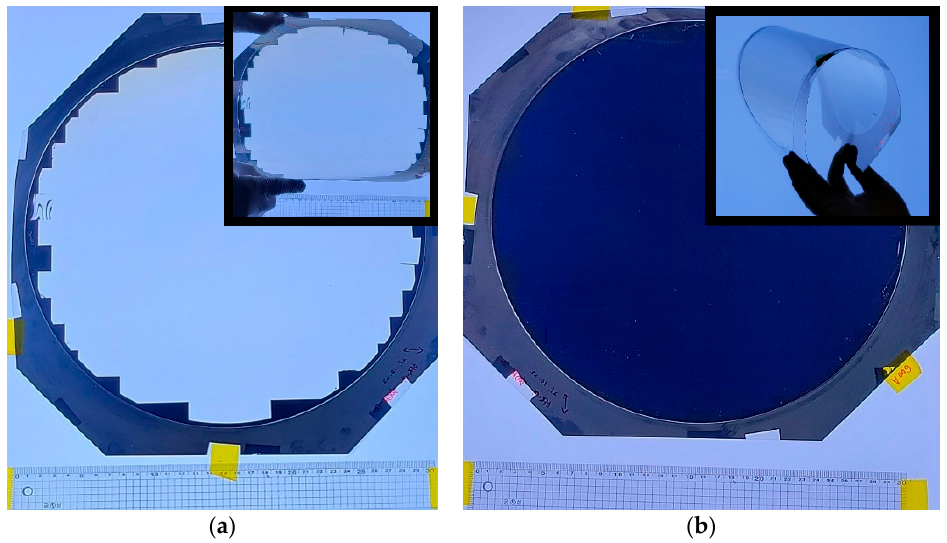
Figure 10. A 300 mm wafer size LA-WGP. ( a ) Tp (PVA film and WGP arranged in parallel) and ( b ) Ts (PVA film and WGP placed vertically). The inlet picture shows that the fabricated LA-WGP is